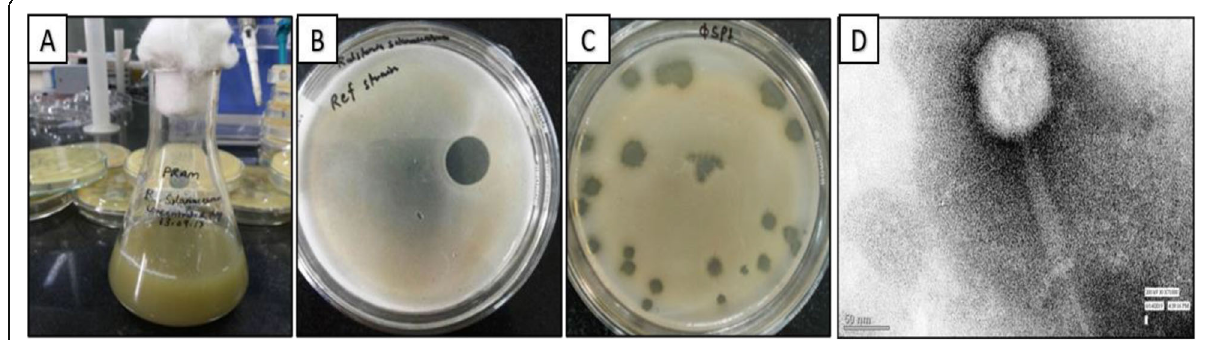
Fig. 1 Isolation and characterization of phage ɸ sp1 against host Ralstonia solanacearum strain 1629. a Propagated phages stock. b Spot test. c ɸ sp1 plaques on double-layer agar plate. d TEM image of phage ɸ sp1 morphology at 200kv